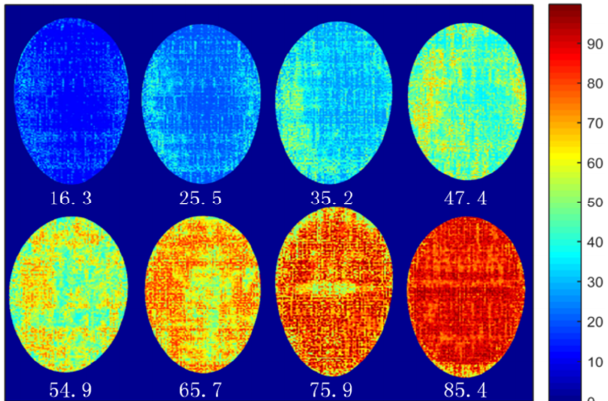
Figure 8. Visualization of S-ovalbumin contents in